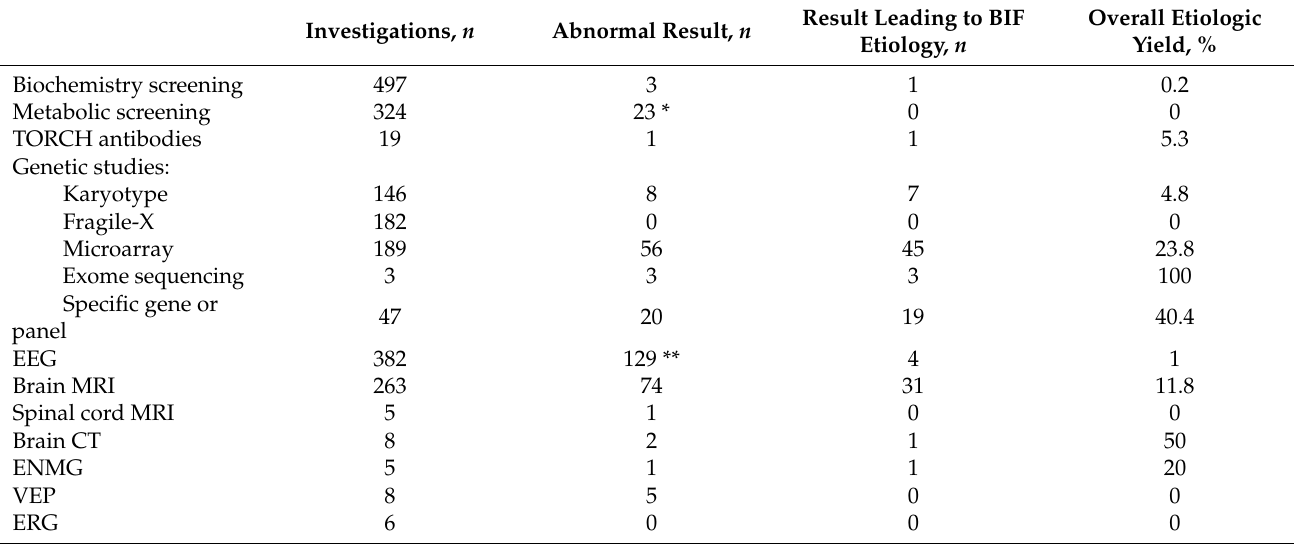
Table 3. Investigations with their yield.